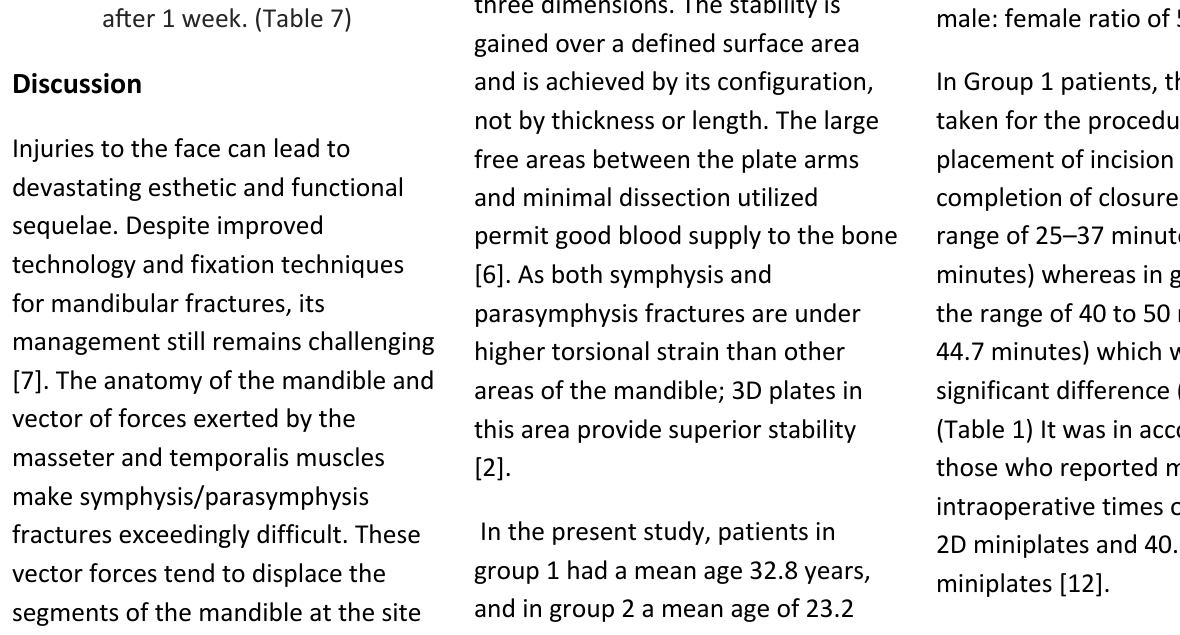
Table 1: Mean time taken for fixation in minutes